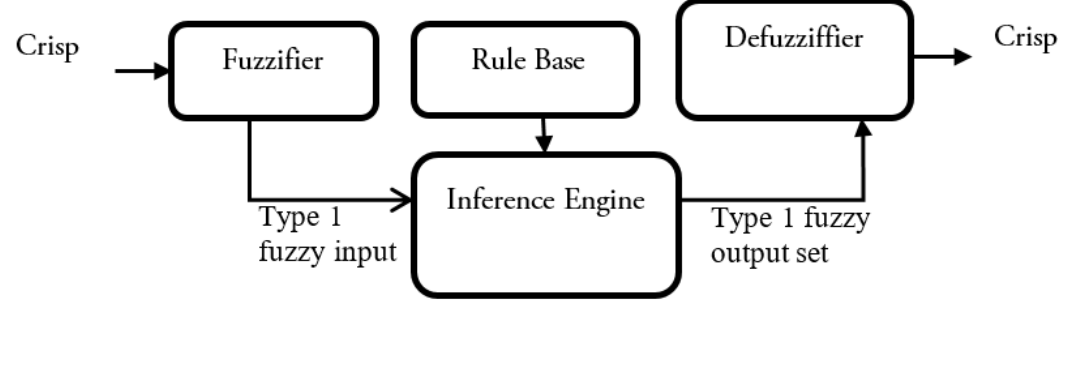
Fig. 1. Structure of a type 1 fuzzy logic system